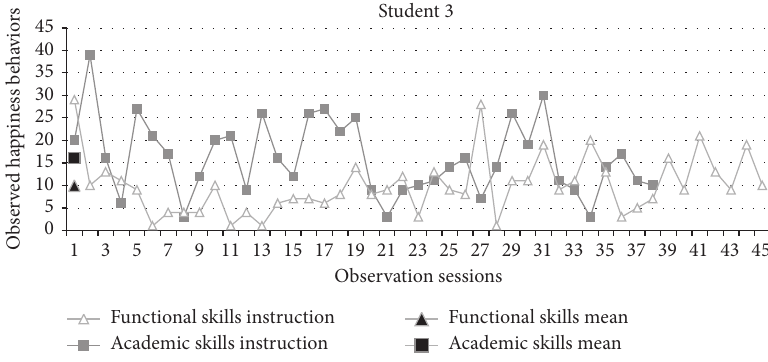
Figure 4: Total frequency of behaviors associated with happiness per observation session for Student 3.